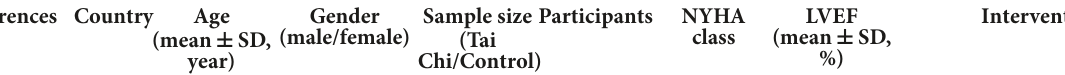
TABLE 1 Characteristics of the 15 trials included in the systematic review and